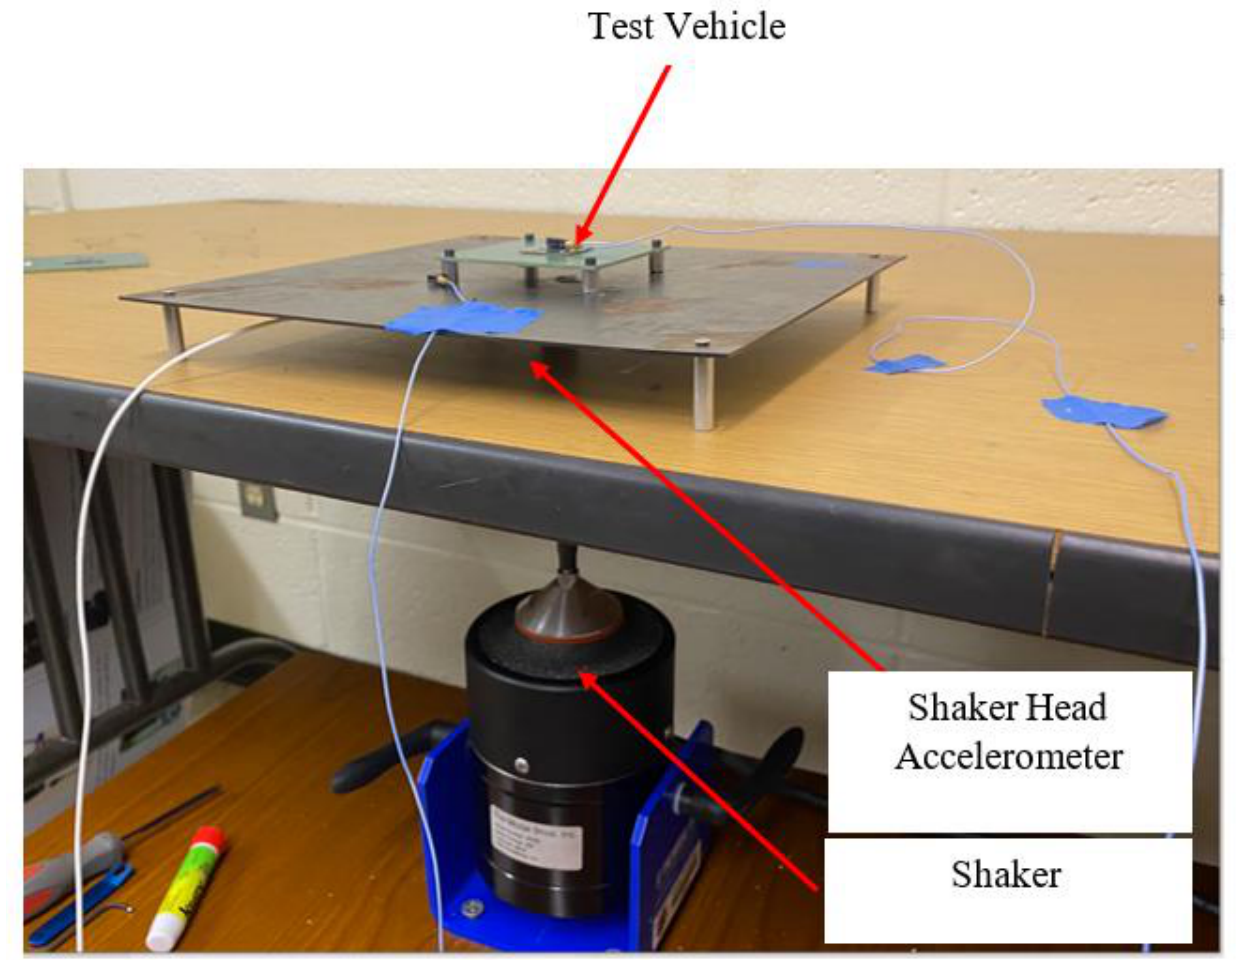
Figure 6. Close-up view of the shaker head accelerometer.